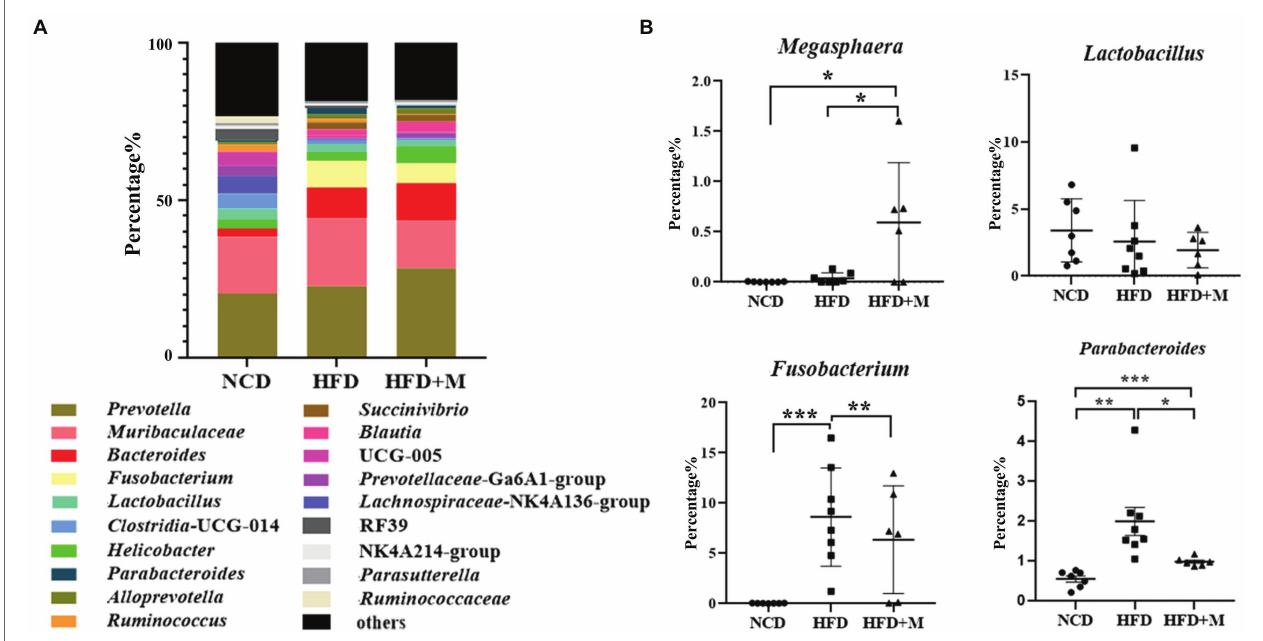
FIGURE 8 | Relative abundances of gut microbiota at genus level in different rat groups. (A) The most abundant genera (top 20) of the gut microbiota in SD rats of different groups. (B) The relative abundance of Megasphaera , Lactobacillus , Parabacteroides, and Fusobacterium in fecal microbiota. NCD, Normal Chow Diet rats;